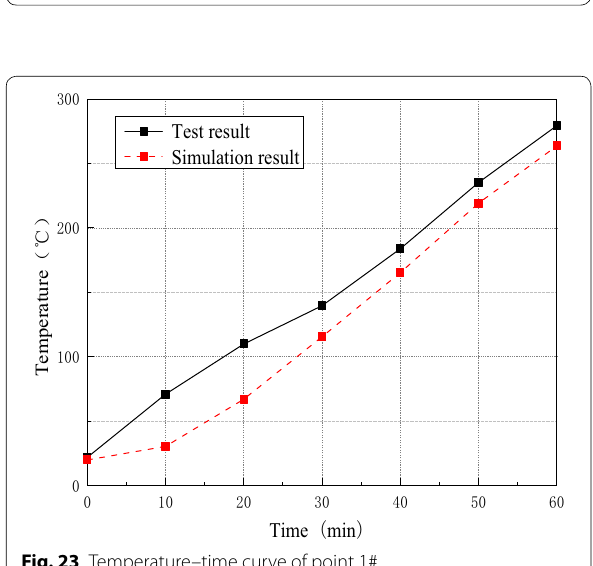
Fig. 23 Temperature–time curve of point 1#